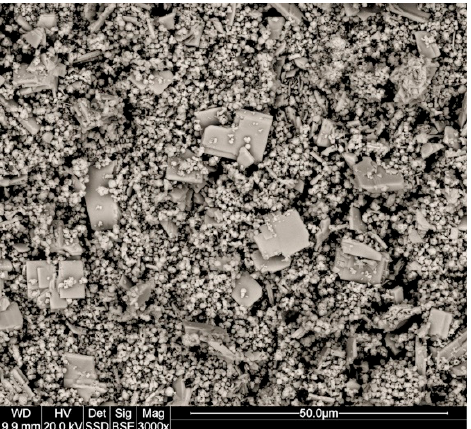
Figure 2. SEM microphotographs of the residual solids from the dissolution experiments of vanadinite. Fine, hexagonal, stubby crystals were identified as vanadinite while notably larger, tabular ones were identified as chervetite.